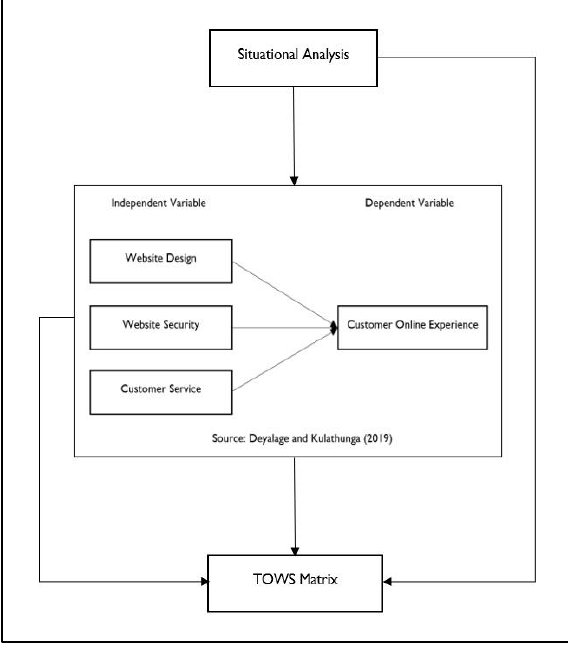
Figure 1: Academic Construct